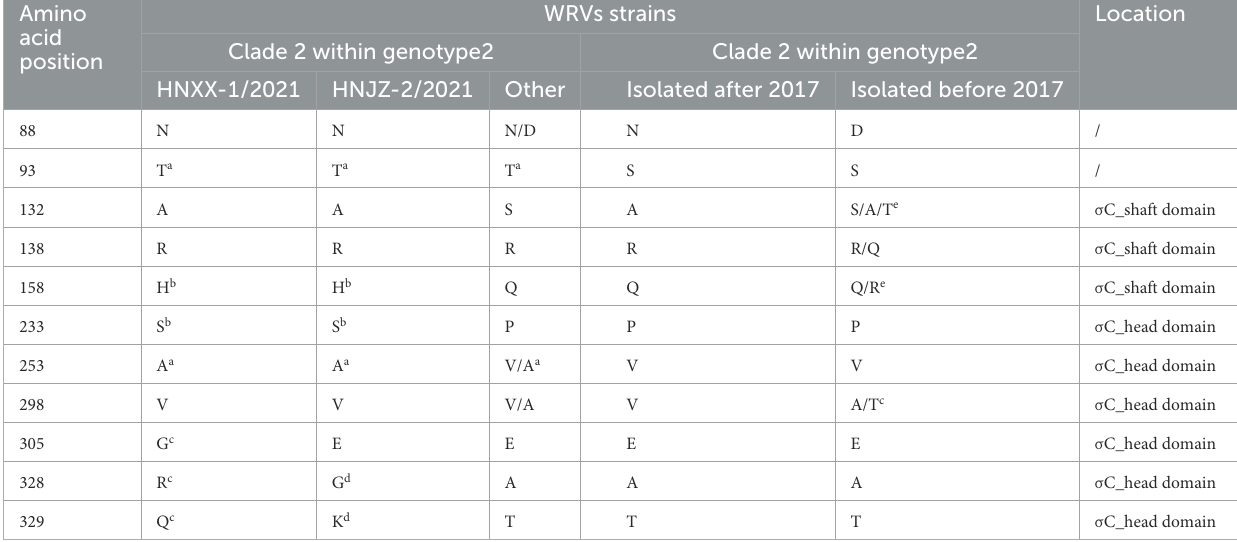
TABLE 1 Amino acid polymorphism of the σ C protein among HNXX-1/2021, HNJZ-2/2021 and other WRVs strains. Amino WRVs strains Location acid Clade 2 within genotype2 Clade 2 within genotype2 position HNXX-1/2021 HNJZ-2/2021 Other Isolated after 2017 Isolated before